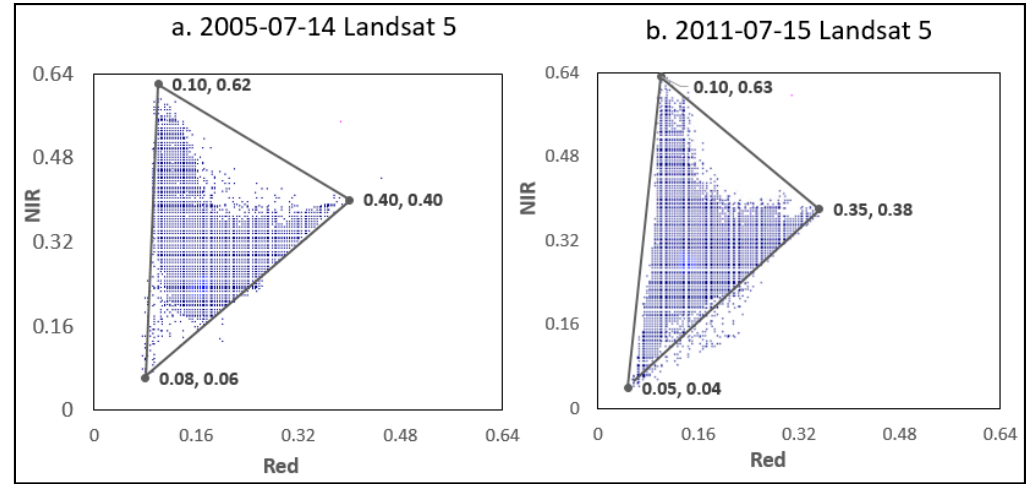
Figure 6. Example two-dimensional image feature spaces constructed from Red and NIR bands ( a ) Landsat 5 image collected from the study area on July 14, 2005; ( b ) Landsat 5 image collected from the study area on July 15, 2011.